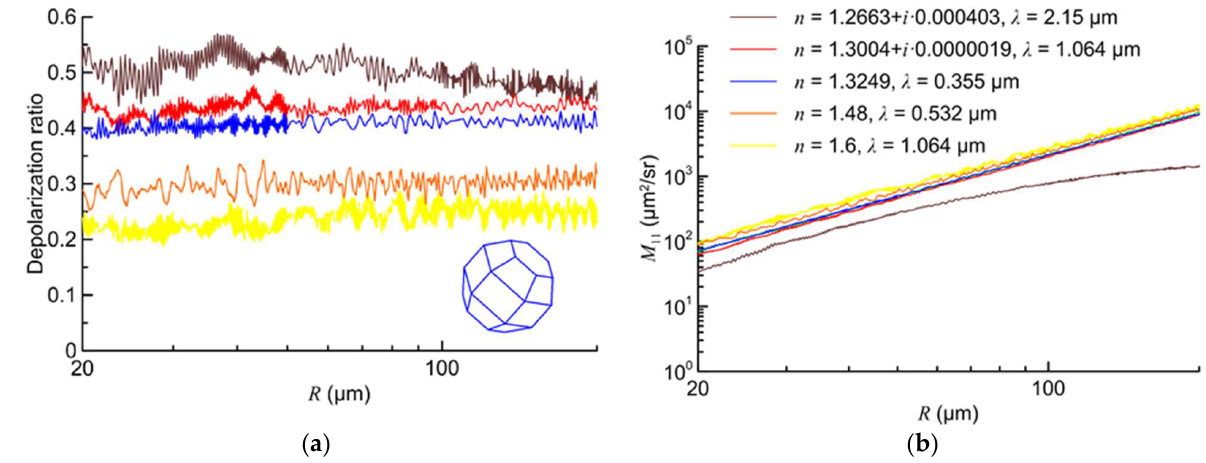
M ( b ) for droxtals at the ar- 11